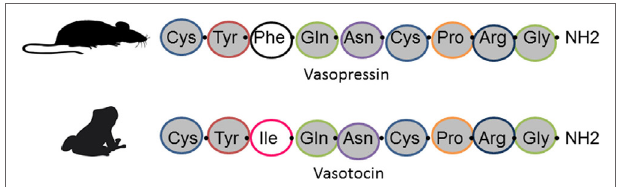
FiGURe 1 | Amino acid sequence in vasopressin (top) found in mammals and arginine vasotocin (bottom) found in amphibians, reptiles, and other non-mammalian